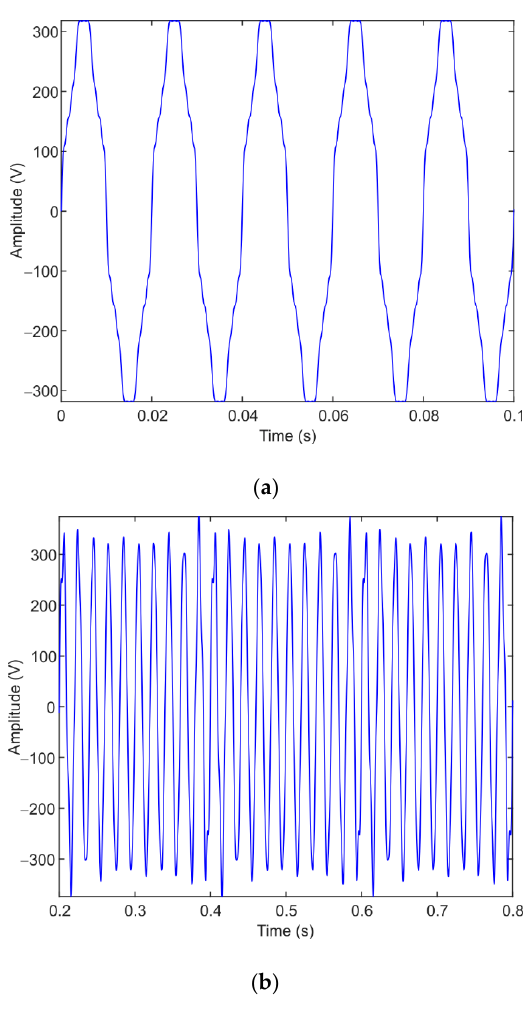
Figure 8. Models of ( a ) harmonic and ( b ) interharmonic disturbances.